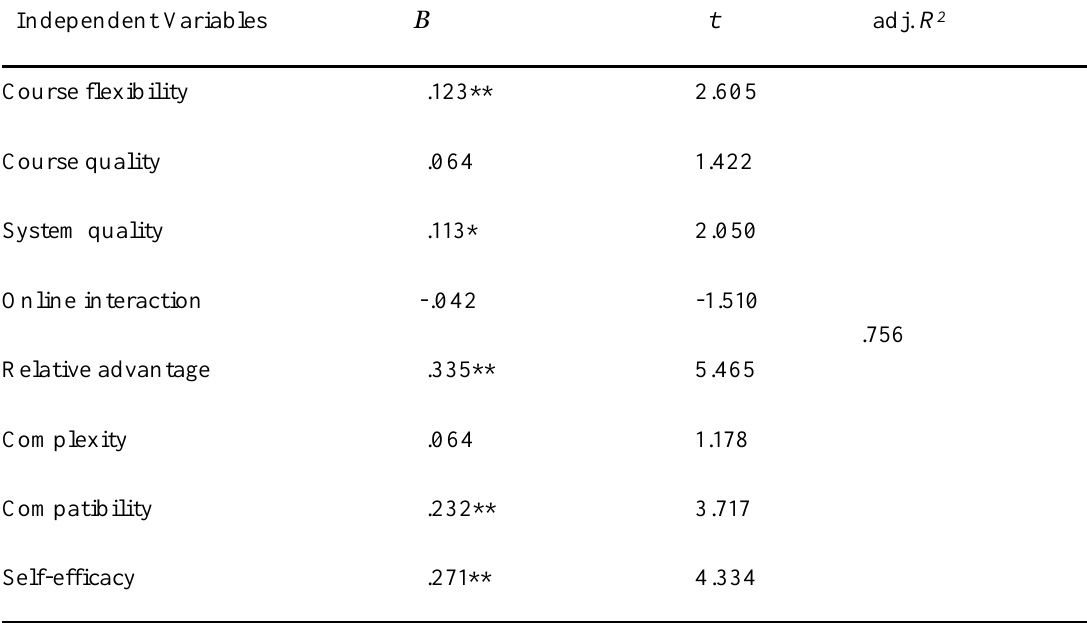
Factors Affecting E-Learning Continuance Intention for the